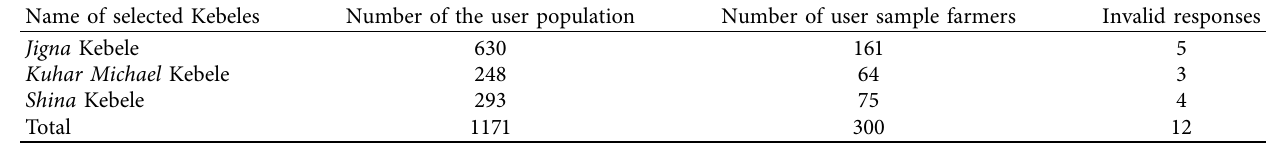
Table 2: Households’ willingness-to-pay status for sustainable irrigation water use.